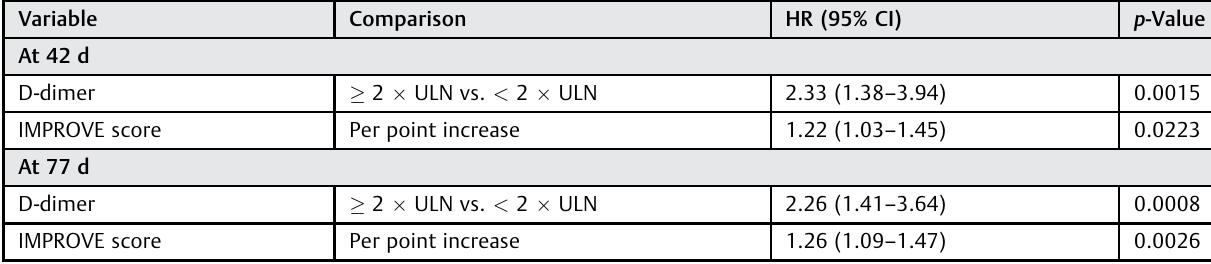
Table 3 Cox proportional hazards model for symptomatic VTE Variable